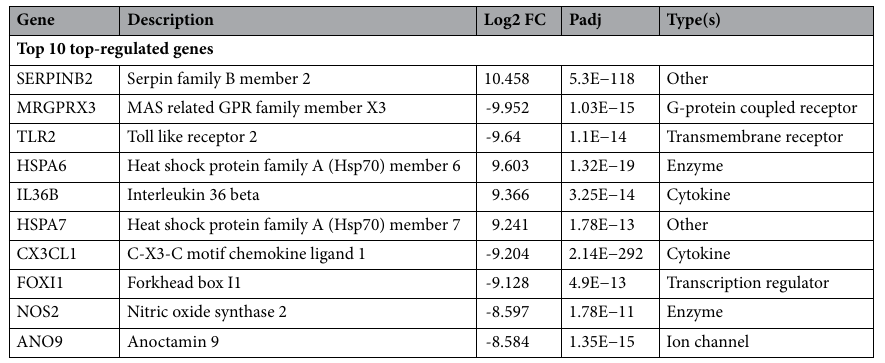
Table 1. Top 10 differentially expressed genes based on comparison of RNA-seq data between TNF-α and NP treated cells (RA-TNF/NP), and TNF-α treated (RA-TNF) RA-FLS